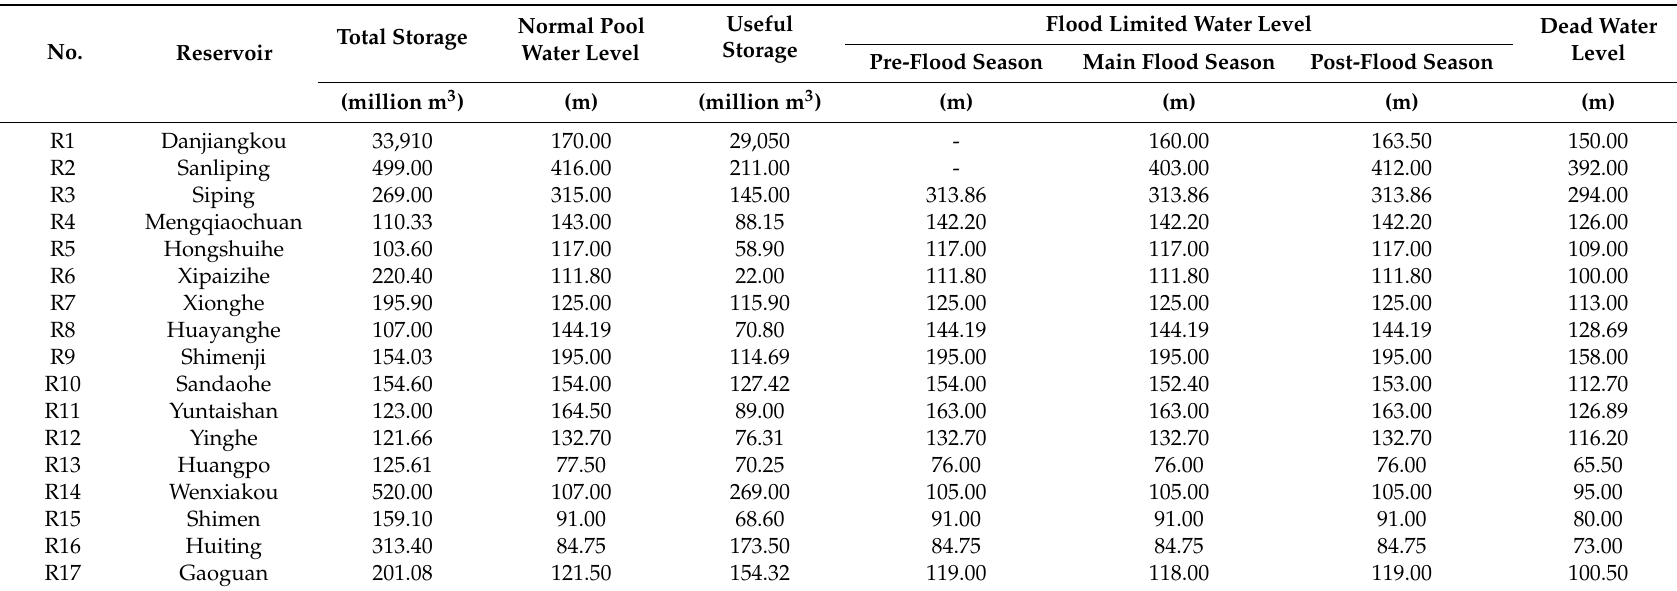
Table 2. Characteristics of reservoirs located in the middle and lower reaches of Hanjiang River